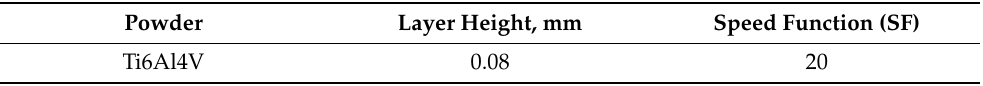
Table 1. Process